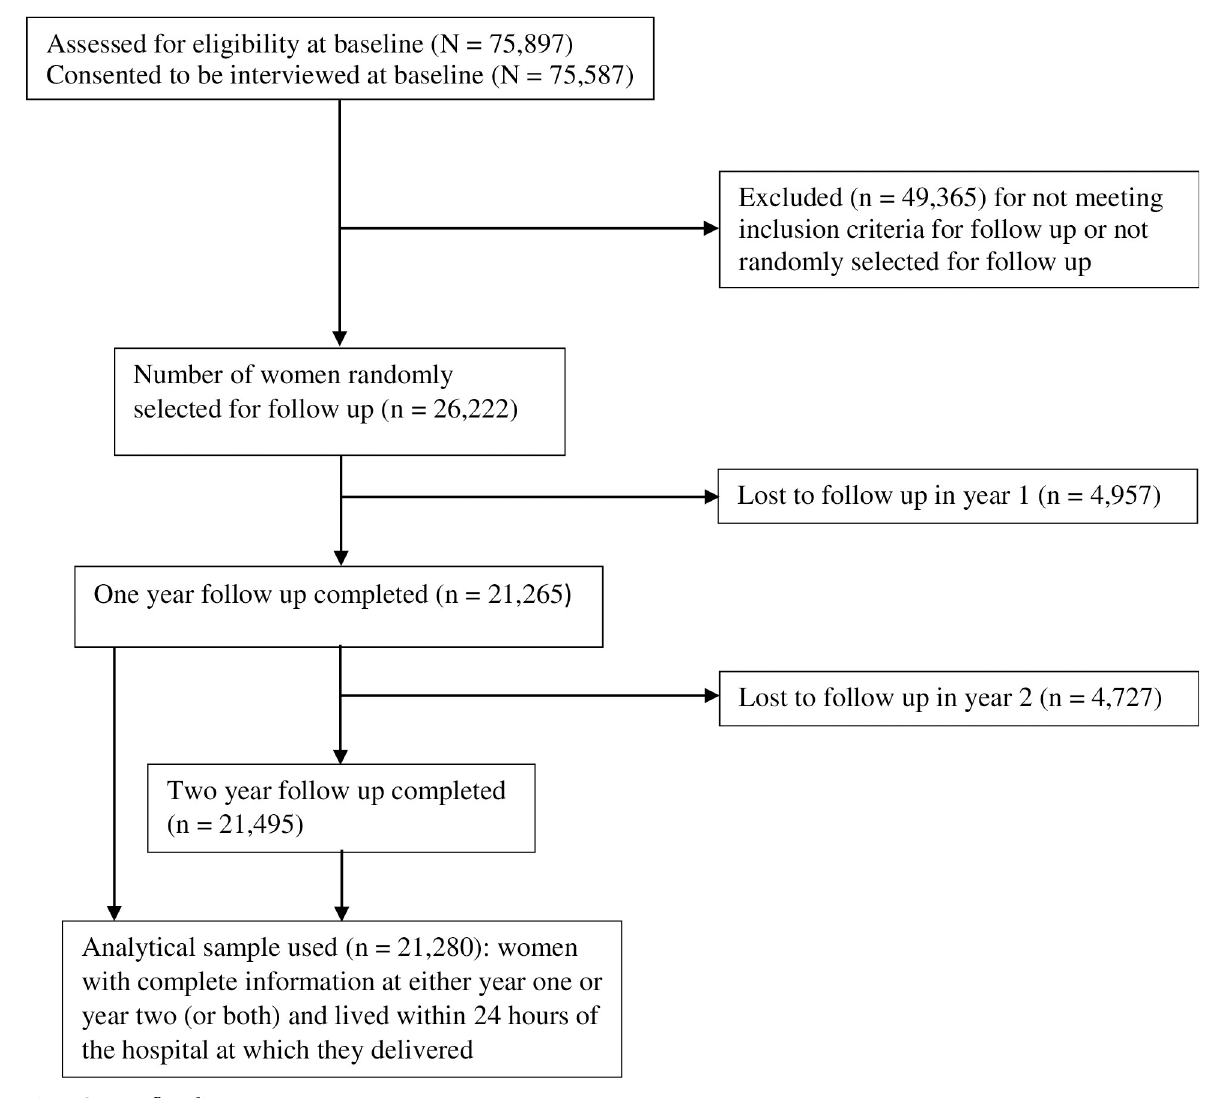
Fig 1. Consort flow